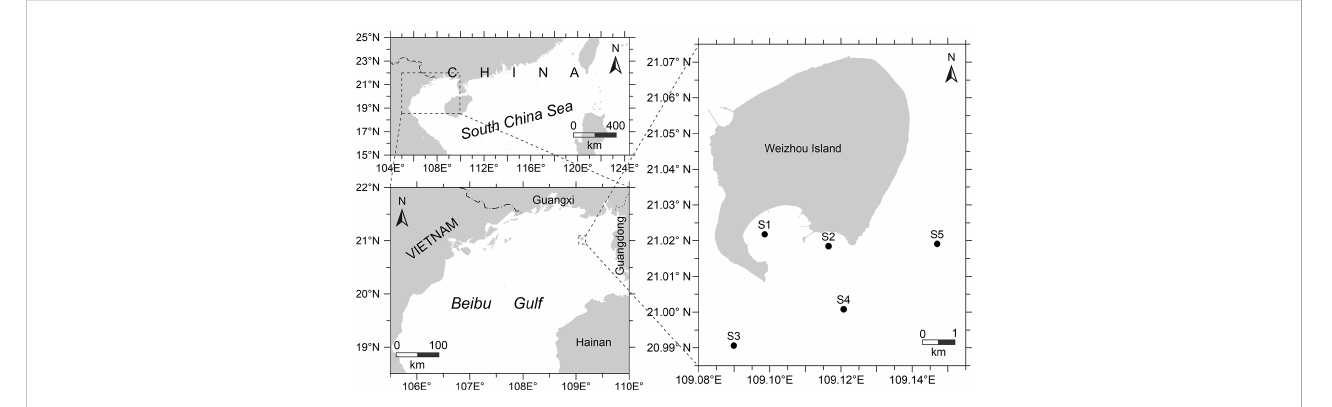
FIGURE 1 Map showing study area and sampling locations in the Beibu Gulf of the South China